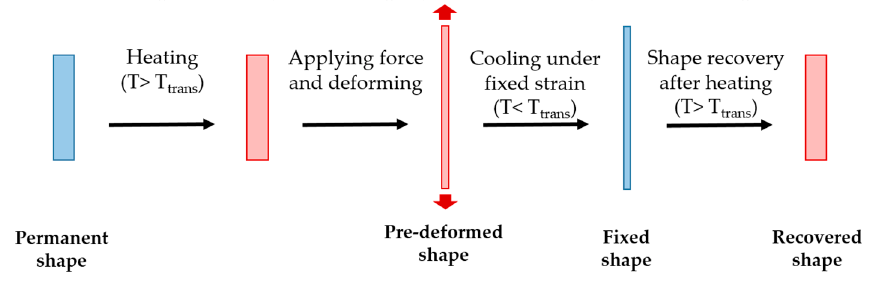
Figure 1. Schematic representation of the basic principle of the shape memory effect in polymers thermally activated.